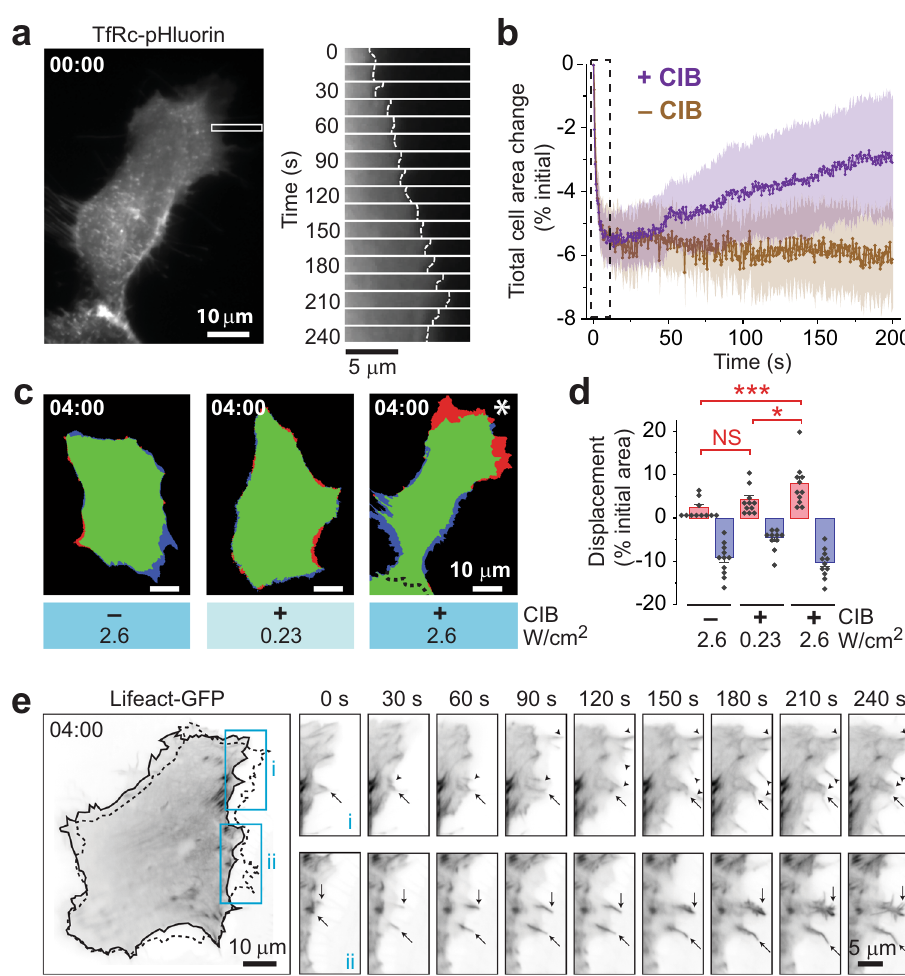
Fig. 6 Only active tethering promotes membrane/actin cytoskeleton remodeling. a Membrane expansion induced by Exo70 optogenetics using the CRY2-CIB system. TIRFM of TfRc-pH in a typical Exo70 optogenetics cell. A crop of a peripheral region (rectangle) shows membrane expansion (gallery, right) during activation. The cell was activated at 2 Hz with 100-ms pulses of 488-nm light (2.6 W/cm 2 ). b Time-course of membrane expansion. n = 11 cells for both + CIB and – CIB. Mean ± SEM. Note the initial retraction caused by light during the fi rst 5 s (dashed box). c Membrane expansion only occurs when active tethering is promoted in cells that express CIB optogenetic bait. Expansion (red)/retraction (blue) map of cells after 4 min. d Quanti fi cation of displacement. n = 11 cells for each condition. Mean ± SEM (* P = 0.046, *** P = 0.0025, NS = not signi fi cant, two-tailed Student ’ s t -test). e Actin remodeling during Exo70 optogenetics visualized with Lifeact-GFP. Dashed outline, cell shape after 4-min activation (left). Image sequence of fi lopodia elongation in areas outlined by cyan rectangles (right). Arrows and arrowheads, pre-existing and new fi lopodia,